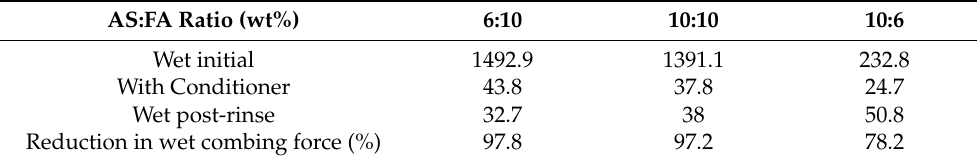
Table 1. Wet combing performance at varied ratios of AminoSensyl™ to Cetyl Alcohol.